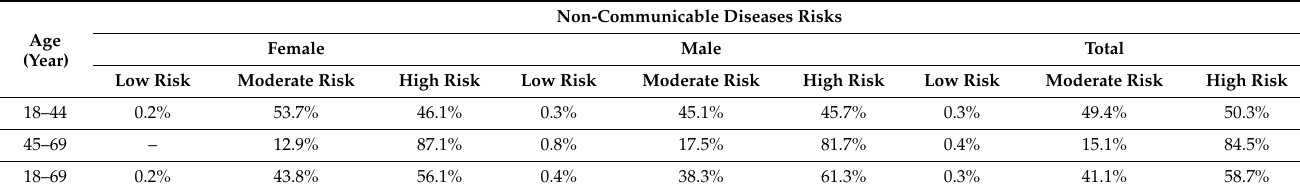
Table 1. Prevalence of risk factors for noncommunicable diseases. High Risk: 3–4 risk factors. Moderate Risk: 1–2 risk factors. Low Risk: 0